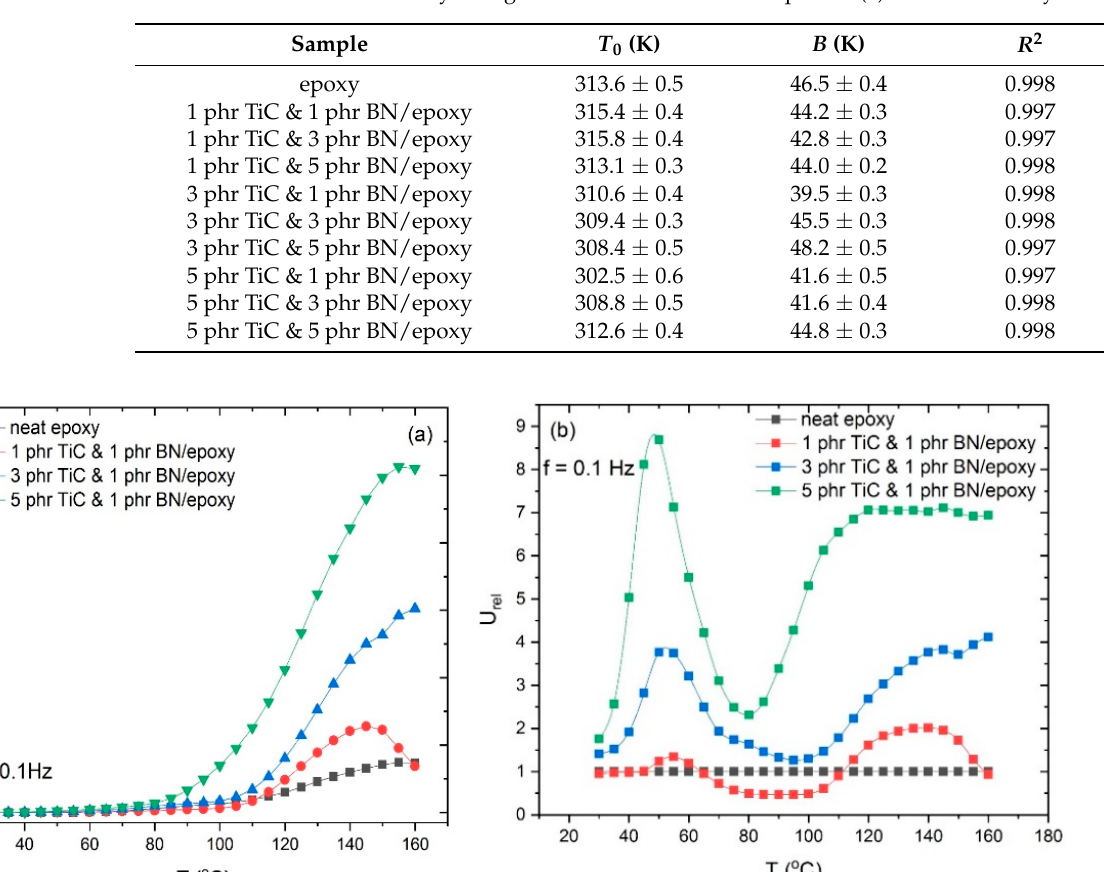
Figure 9. Dielectric loss peak position for α -relaxation, as a function of reciprocal temperature for all studied systems. Table 1. Parameters obtained by fitting data for α -relaxation via Equation (4) for all studied systems.